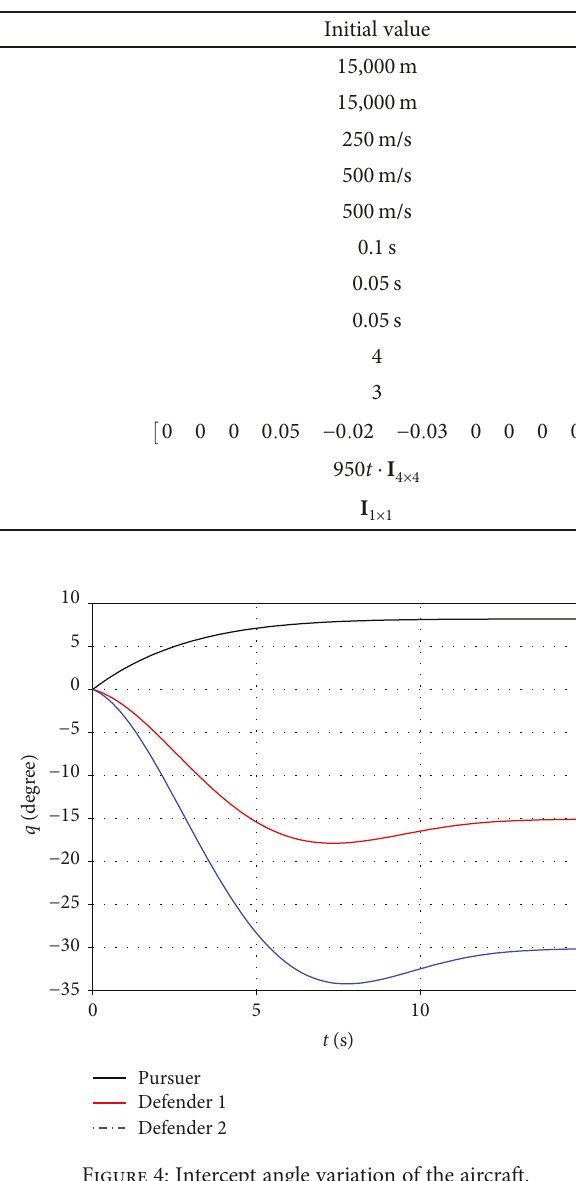
Table 1: Simulation parameters for cooperative intercept.